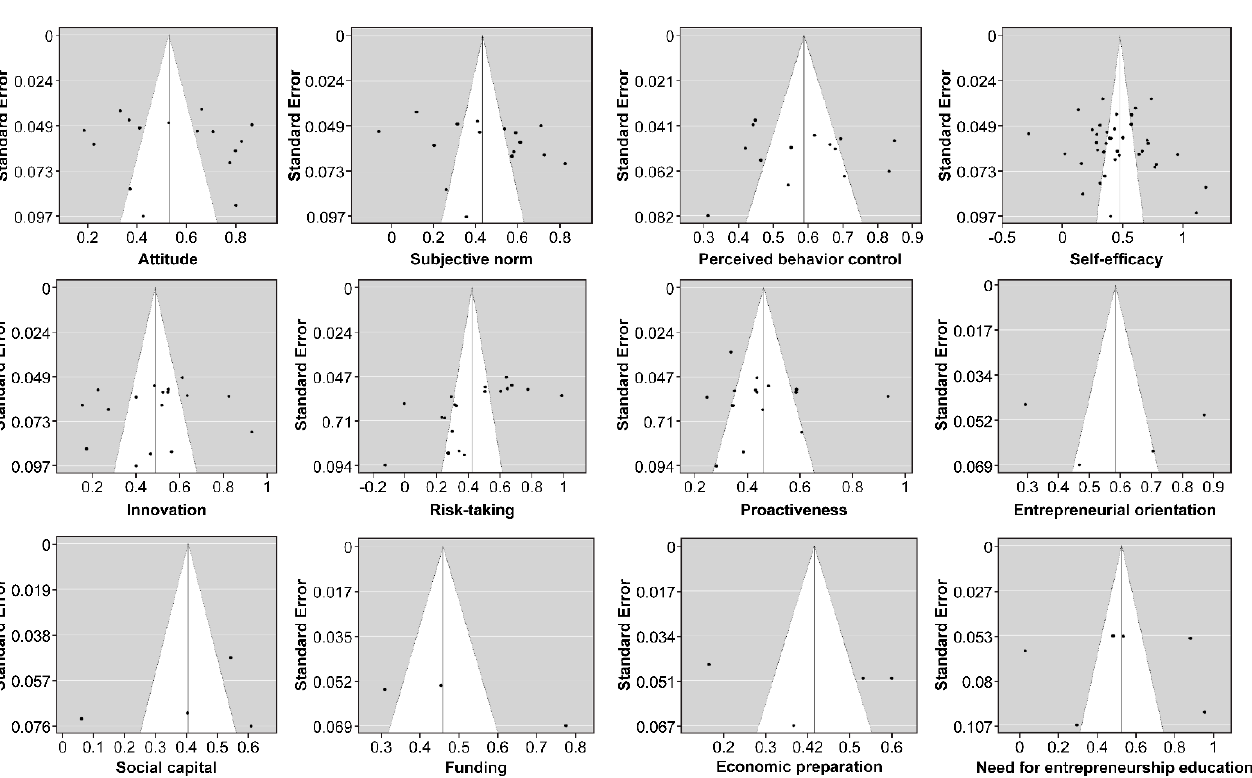
Figure 2. Summary of funnel plots.